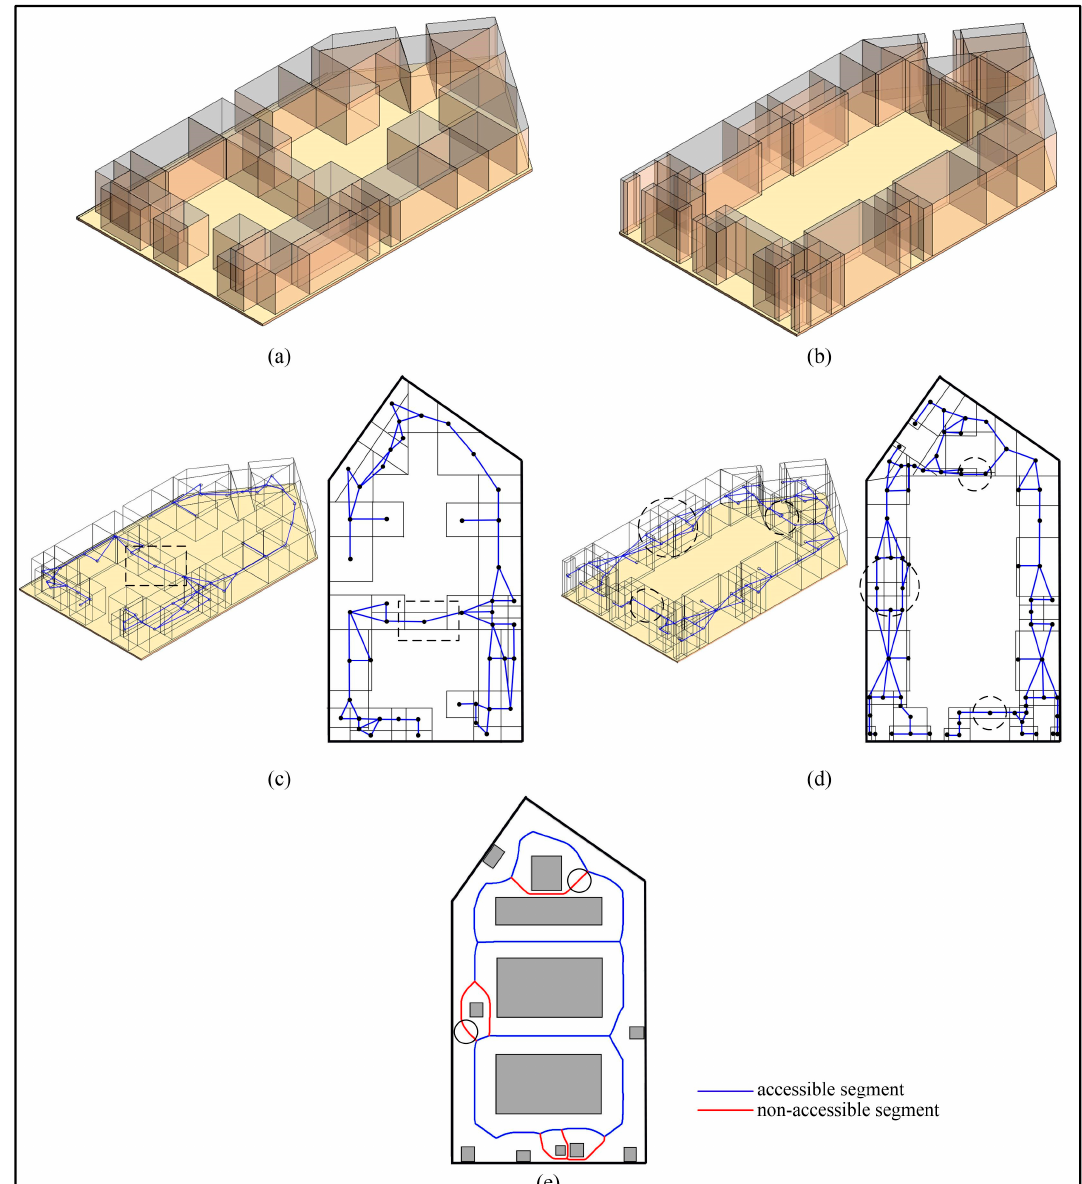
Figure 17. Generation of a navigation network. ( a ) Full convex subdivision of the CN-Space. ( b ) Full convex subdivision of the navigable space using the FSS framework. ( c ) Full connectivity graph of the CN-Space. ( d ) Full connectivity graph of the navigable space using the FSS framework. ( e ) The navigation network generated by the AccessVOR framework.